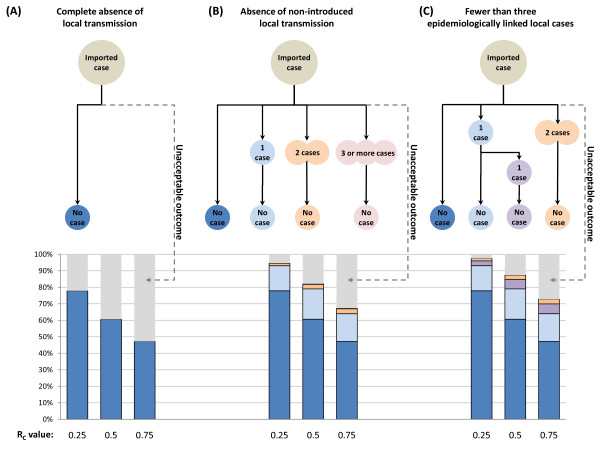
Branching process diagrams for three definitions of elimination. The Poisson probability of each branch permitted under three elimination definitions and the total probability of all other unacceptable outcomes are depicted for three RC values.